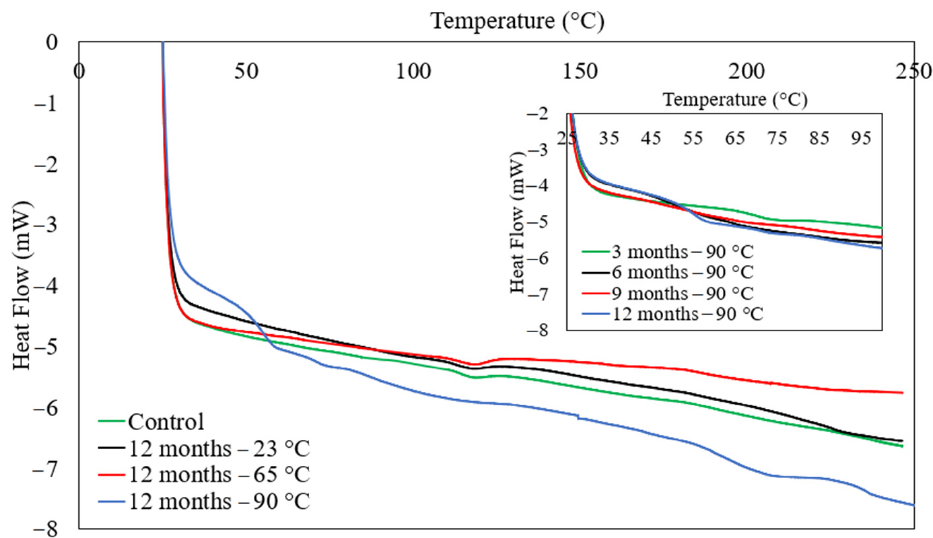
Figure 11. DSC curves for E-glass/epoxy control sample and conditioned samples.